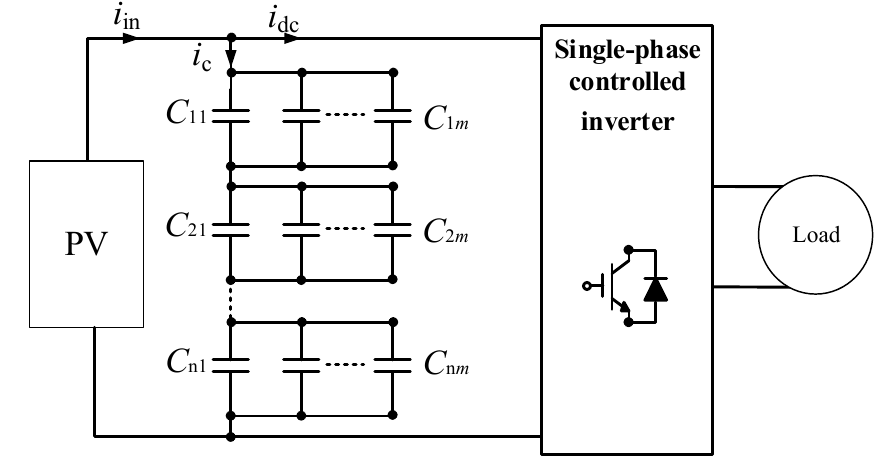
Figure 15. Single-phase photovoltaic (PV) system with capacitor bank.